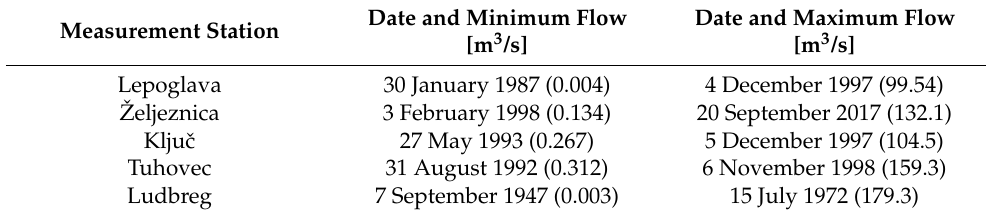
Table 2. Flow values at measurement stations on Bednja River [20].